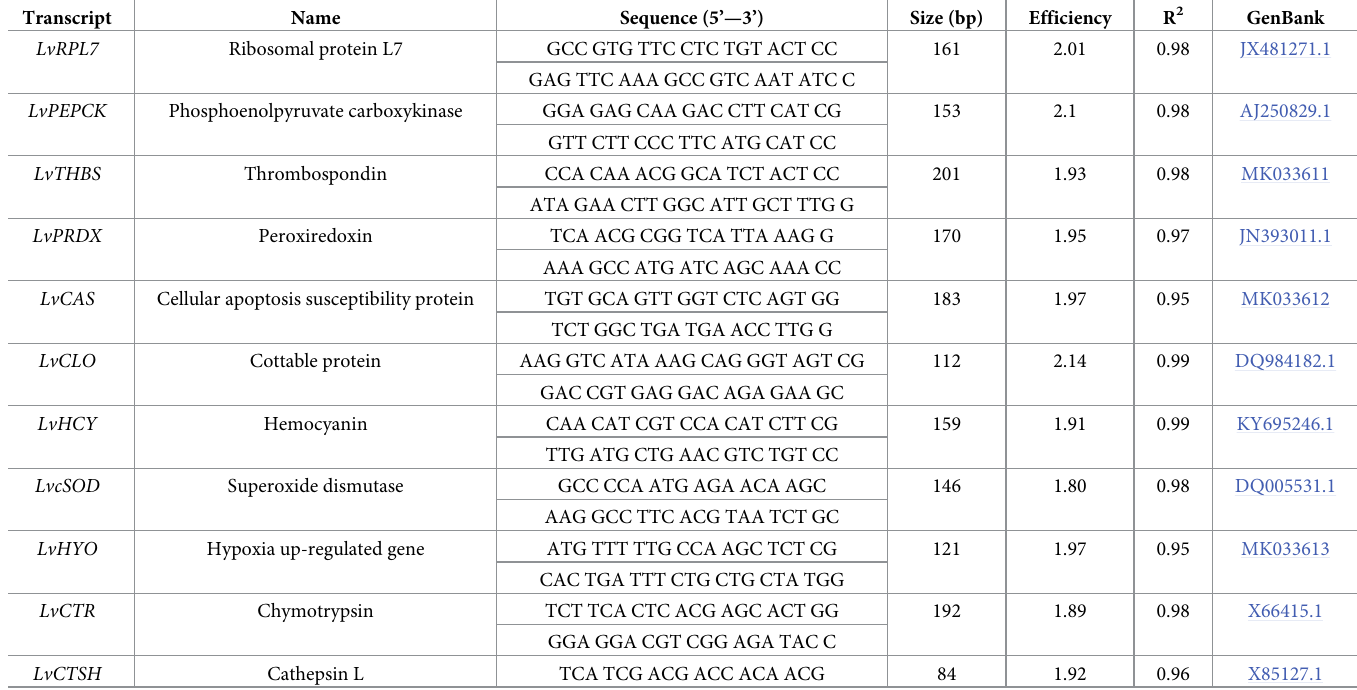
Table 1. Transcript selection and primer design summary. Size refers to qPCR amplicon; efficiency was calculated with a serial dilution of 4-fold.